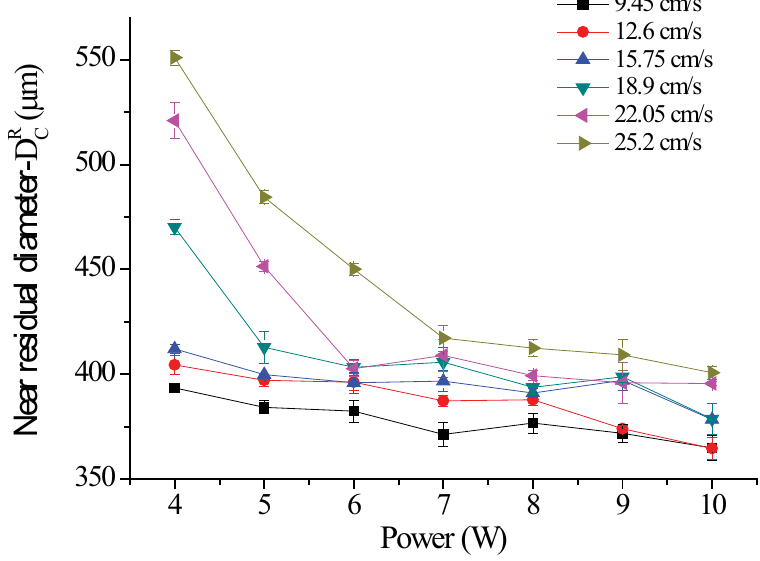
Figure 16. Schematic of the size analysis results (Scanning path: